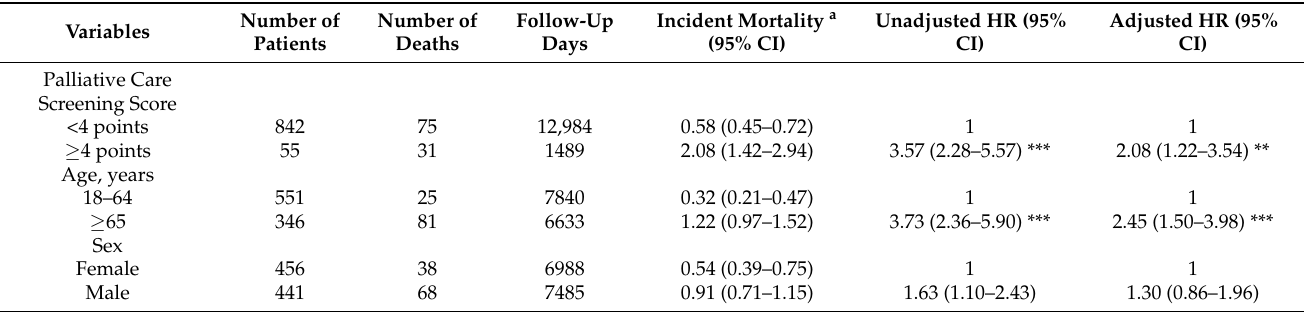
Table 2. Univariate and multivariate analysis of factors associated with incident death among patients with